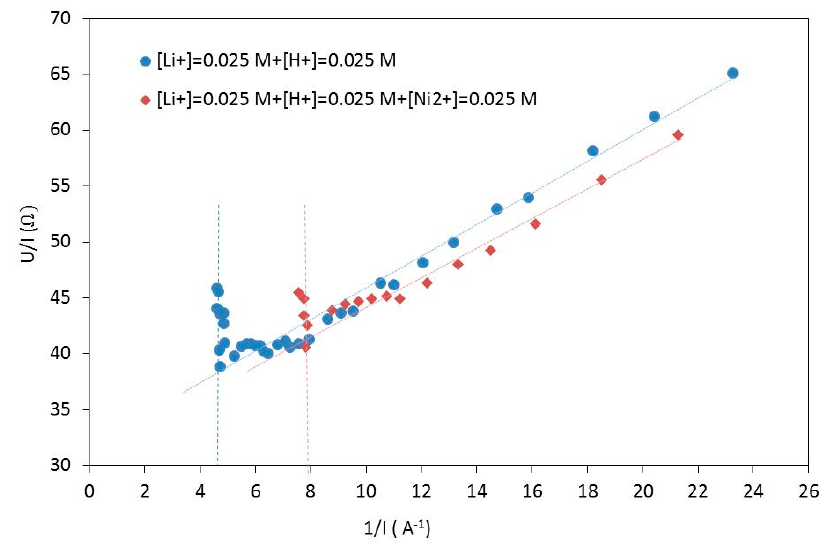
Figure 4. Determination of the limiting current density by using the ED configuration 2 reported in Figure 1c (Flow rate = 100 mL min − 1 ; cathodic and anodic compartments = 0.1 mol L − 1 H 2 SO 4 ; Feed solution: [Li + ] = [H + ] = 0.025 mol L − 1 or [Li + ] = [H + ] = [Ni 2+ ] = 0.025 mol L − 1 , Neosepta ® monovalent-selective cationic exchange membrane). The concentration profiles of lithium(I) and divalent cations in the boundary layer at the vicinity of the membrane depicted in Figure 5 depends on the difference in transport numbers between the bulk and into the membrane.